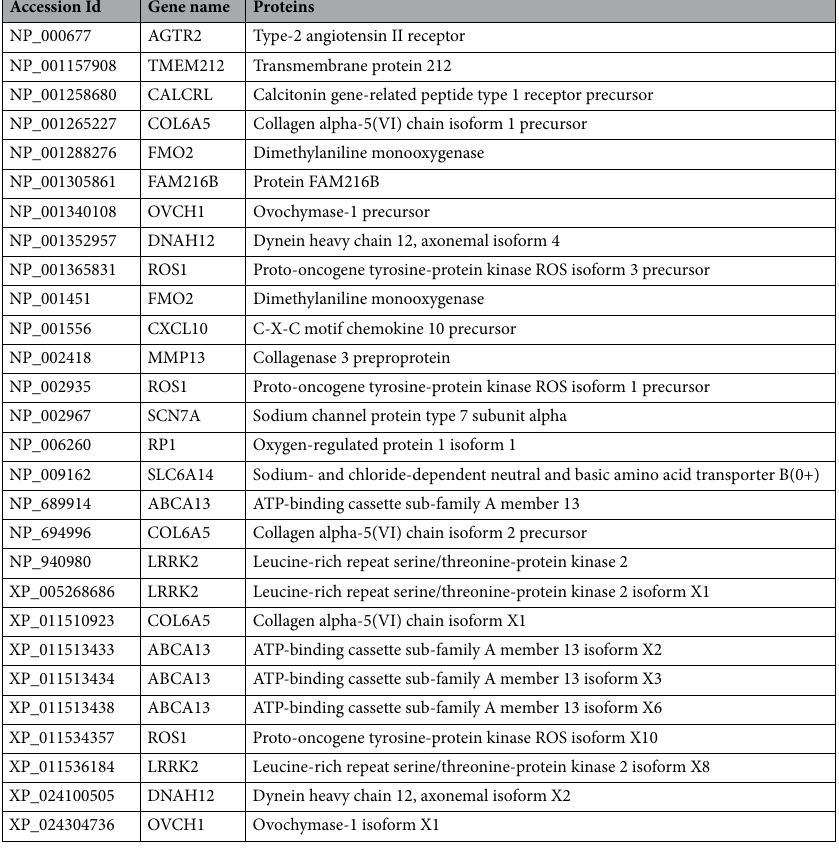
hand, ORF6 grouped with TSPAN19 (2), (Supplementary Information 7B). The differences observed between the groups of human SARS-CoV-2 and the animal SARS-CoV-2-like with the overexpressed human genes were statistically significant according to the chi-square test (p-value of 1.039e –15 , Kruskal–Wallis rank sum test and corrected FDR). The clustering between the human genes and the viral genes of the bat SARS-like showed that only 2 out of 12 clusters contained viral and human genes. The membrane glycoprotein M and the nucleocapsid protein N grouped with 7 human genes: IFNG, AGTR2, TMEM212, CALCRL, FMO2 (2) and MMP13. And the ORF6 grouped with TSPAN19 (2), DNAAF6 and PIH1D3 (Supplementary Information 7C). With respect to the SARS- like coming from the civets, 3 out of 12 clusters contained human and viral genes. One of the clusters grouped the human gene CXCL10 (1) with 5 viral genes: hypothetical protein (3), ORF1ab, and the spike protein S. Other cluster comprised 16 human genes: AGTR2 (1), C7orf77 (1), DCSTAMP (2), FAM216B (1), FMO2 (2), IFNG hypothetical viral protein (Supplementary Information 7D). The difference observed among the clusters were statistically significant according to the chi-square test (p-value of 2.35e –12 , Kruskal–Wallis rank sum test and corrected FDR). For the bat MERS-like virus 3 out of 12 clusters contained viral and human genes. The ORF4a grouped with with BCL2A1 (2) (Supplementary Information 7E). Regarding the hedgehogs MERS-like, 3 out of 12 clusters contained human and viral genes. The human gene CXCL10 (1) grouped with 8 viral genes: the membrane glycoprotein M, the nucleocapsid protein N, ORF1a, ORF1ab, ORF3a, ORF4b, ORF5, and the spike protein S. In other cluster the envelope protein E grouped with 3 human genes, the SDR16C5 (3). On the other hand, the viral ORF8b gene grouped with the human gene IFNG (1) (Supplementary Information 7F). These differences among the clusters between animals and human viruses were statistically significant according to the chi-square test (p-value of 6.5e –13 , Kruskal–Wallis rank sum test and corrected FDR). These results showed that in all the cases, the number of clusters containing both, overexpressed human genes and viral genes coming from the human SARS-CoV-2, SARS and MERS was higher than in the control clustering using viral genes coming from animal hosts. Moreover, the number of human genes and viral genes